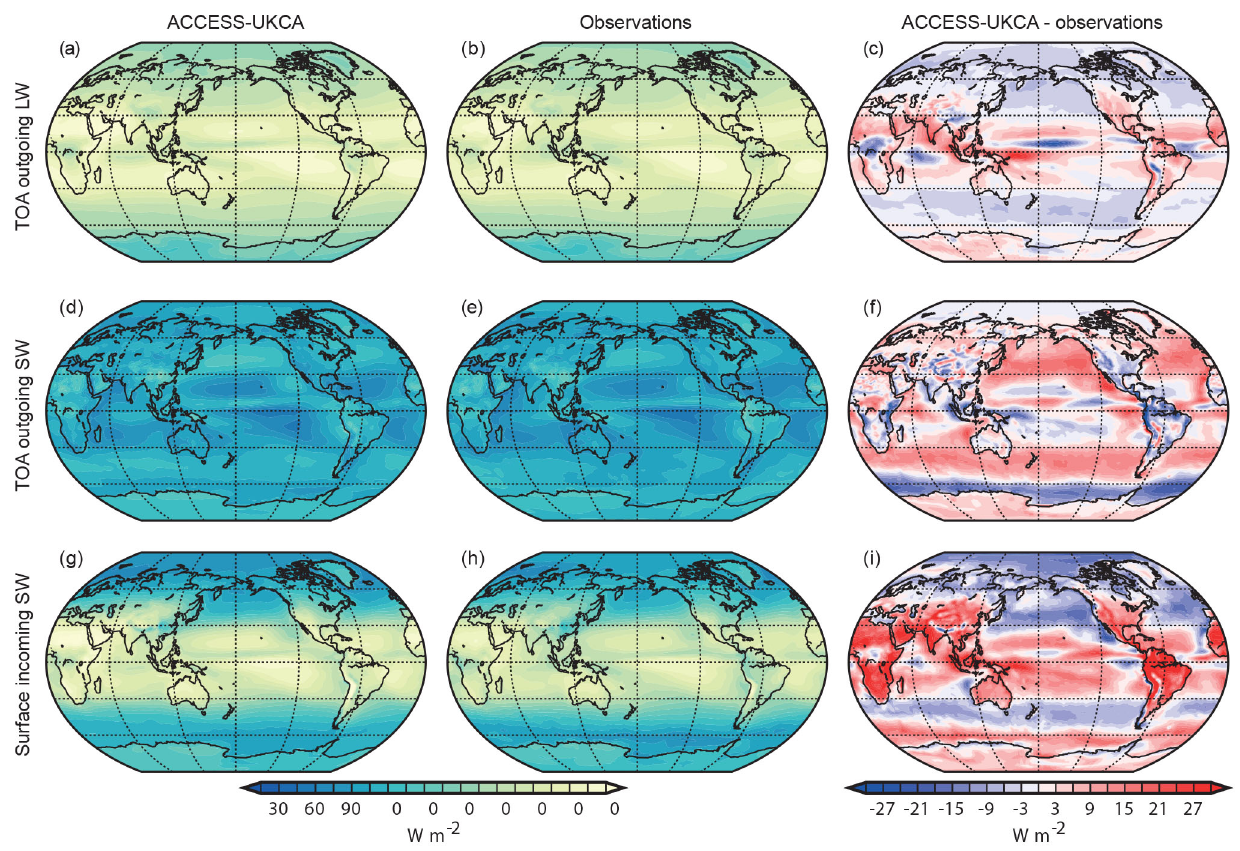
Figure 4. As for Fig. 3 but for annual means for 2000–2009, where (a) , (b) and (c) show the TOA outgoing LW radiation, (d) , (e) and (f) show TOA outgoing SW radiation and (g) , (h) and (i) show surface incoming SW radiation. The observations are from the CERES EBAF TOA and Surface Ed. 4.0 (Loeb et al., 2009; Kato et al., 2013); all units are in Wm − 2 .